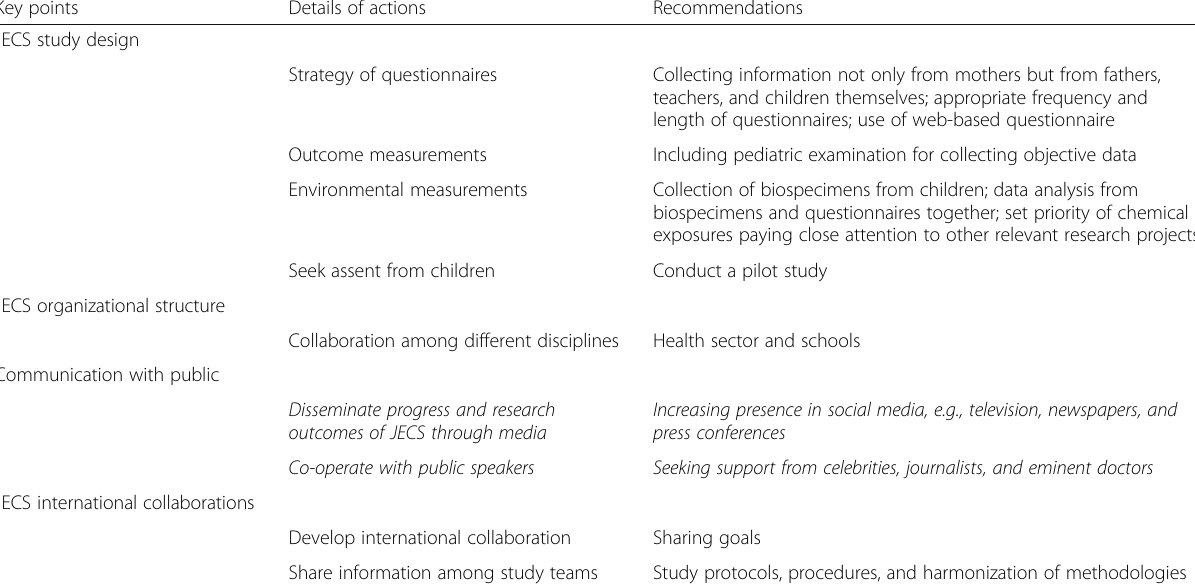
Table 4 Main recommendations of International Advisory Board